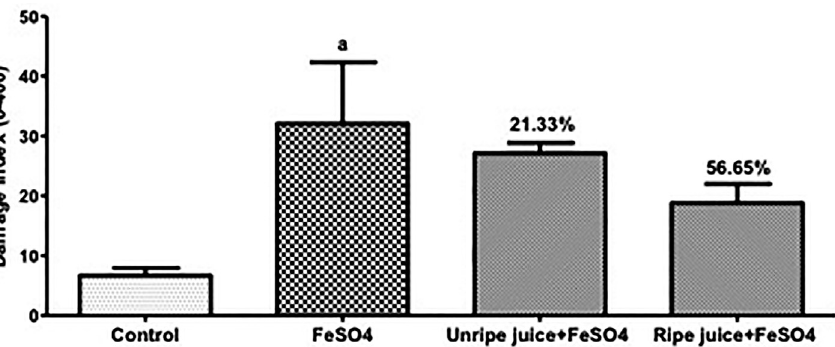
Figure 1 - Modulation of DNA damage induced by FeSO 4 by pre-treatment with unripe (21.33%) and ripe acerola (56.65%) juices evaluated by Comet assay. a Significant compared to control group at P <